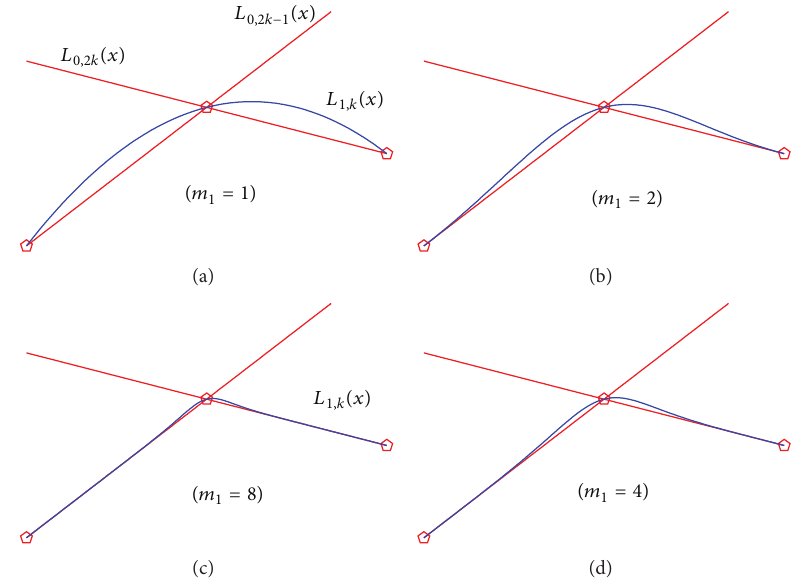
Figure 2: Effect of the first step ( 𝑗 = 1) smoothening 𝐿 1 ,𝑘 (𝑥) for each of the orders 𝑚 1 = 1 , 2 , 4 , 8 of the weight function V 1 ,𝑘 (𝑥) .